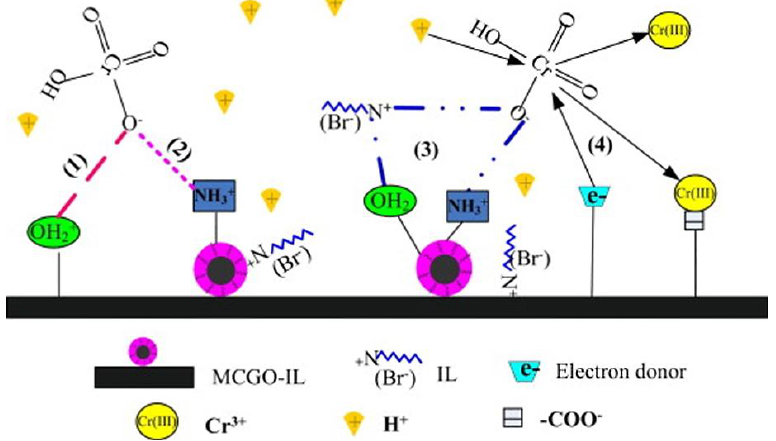
Figure 11. Proposed mechanism of Cr(VI) removal by magnetic CS/GO/ionic liquid nanocomposite. Reprinted with permission by Elsevier